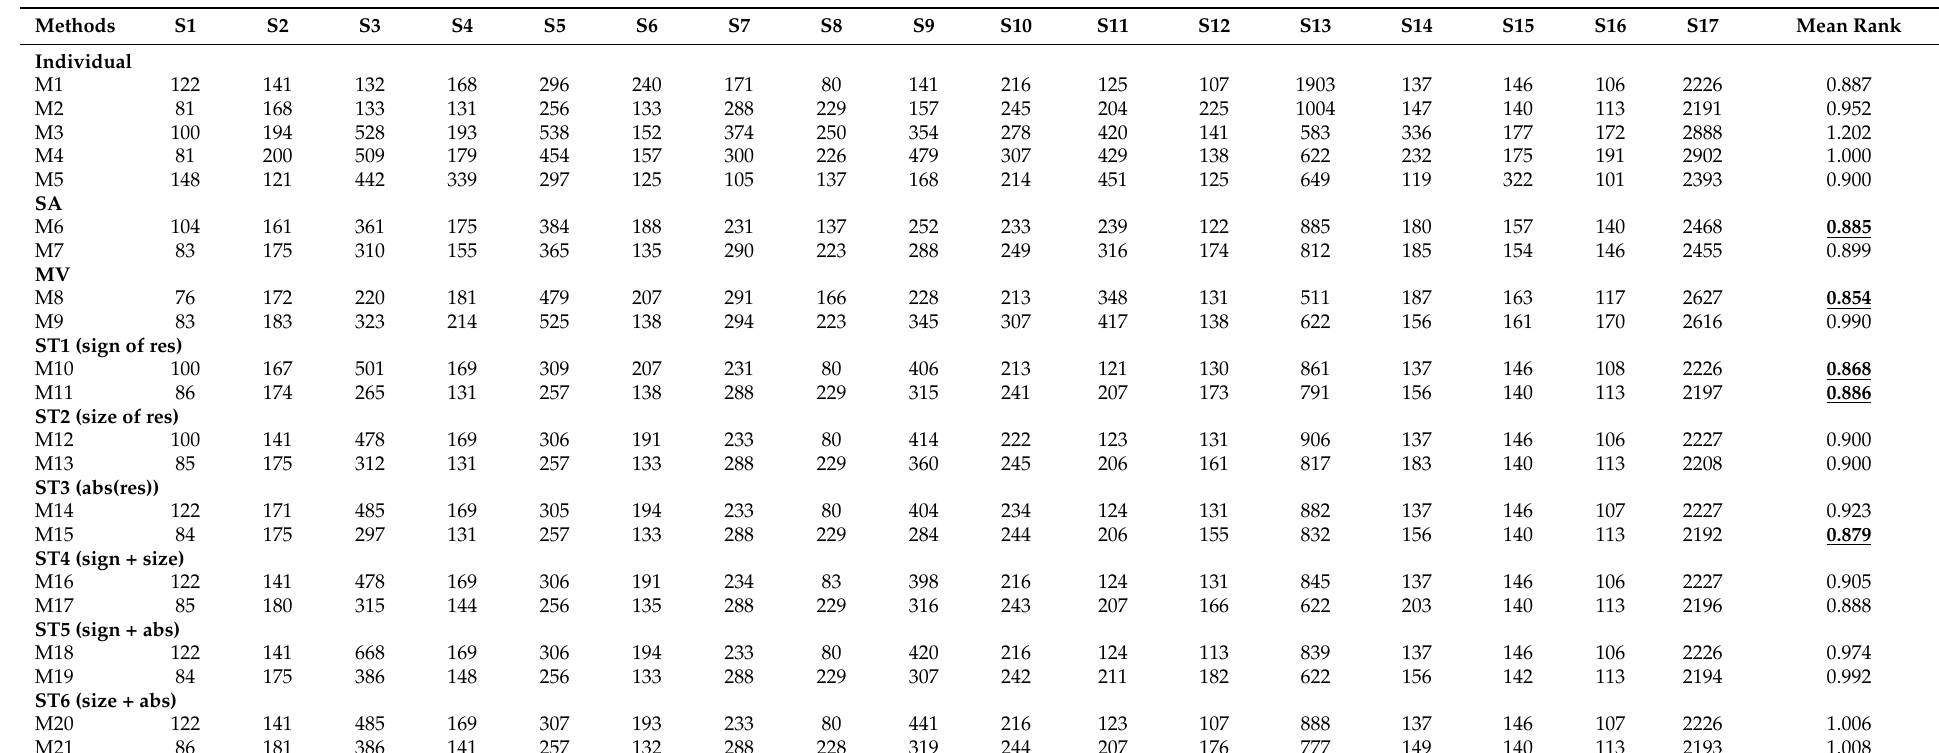
Table 11. MAE ( × 10 4 ) for out-of-sample in tourism demand volatility